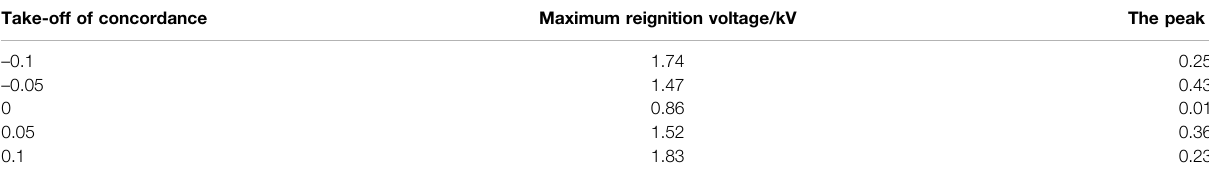
TABLE 1 | Maximum reignition voltage under different detuning degrees of the distribution network. Take-off of concordance Maximum reignition voltage/kV The peak time/s –